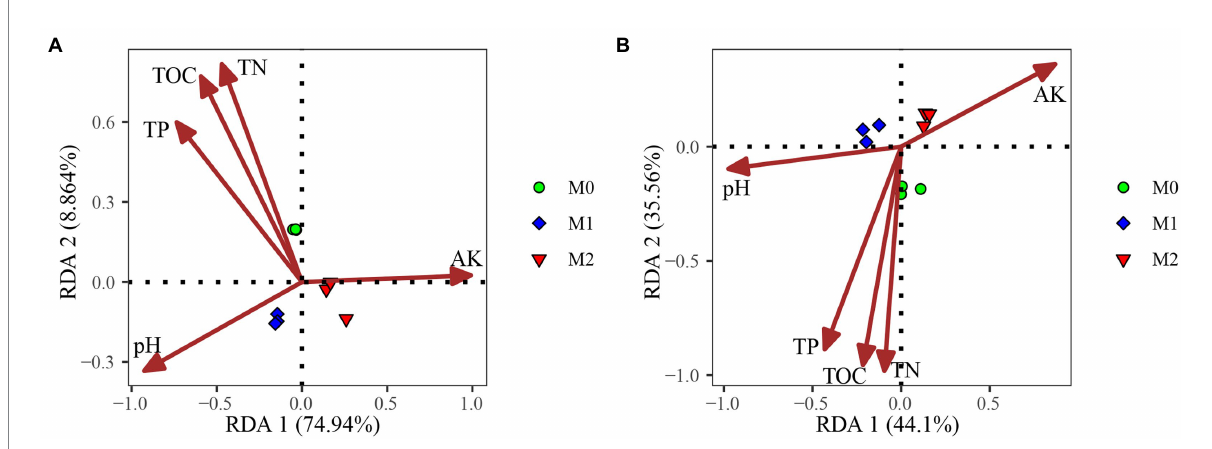
FIGURE 4 Redundancy analysis of soil properties and microbial CAZyme genes for the plant- (A) and microbial-derived (B) biomass decomposing in the bamboo plantations under different management practices.